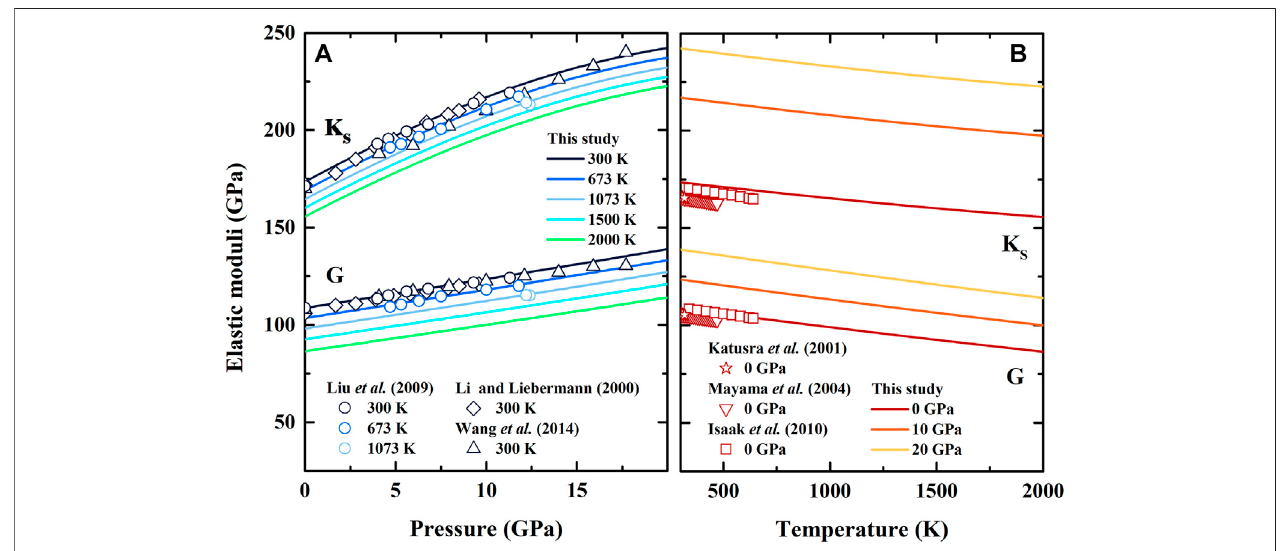
FIGURE 2 | Adiabatic bulk modulus ( K S ) and shear modulus ( G ) of Fe-bearing wadsleyite as a function of (A) pressure and (B) temperature. Solid lines: result of β - (Mg 0.87 Fe 0.13 ) 2 SiO 4 from this study; Diamonds: result of β -(Mg 0.88 Fe 0.12 ) 2 SiO 4 obtained from ultrasonic measurement by Li and Liebermann (2000); Circles: result of β - (Mg 0.87 Fe 0.13 ) 2 SiO 4 obtained from ultrasonic measurement by Liu et al. (2009); Triangles: result of β -(Mg 0.925 Fe 0.075 ) 2 SiO 4 obtained from Brillouin scattering measurement by Wang et al. (2014); Stars, inverted triangles and squares: results of β -(Mg 0.91 Fe 0.09 ) 2 SiO 4 obtained from resonant ultrasound spectroscopy measurements by Katsura et al. (2001), Mayama, (2004) and Isaak et al. (2010), respectively.